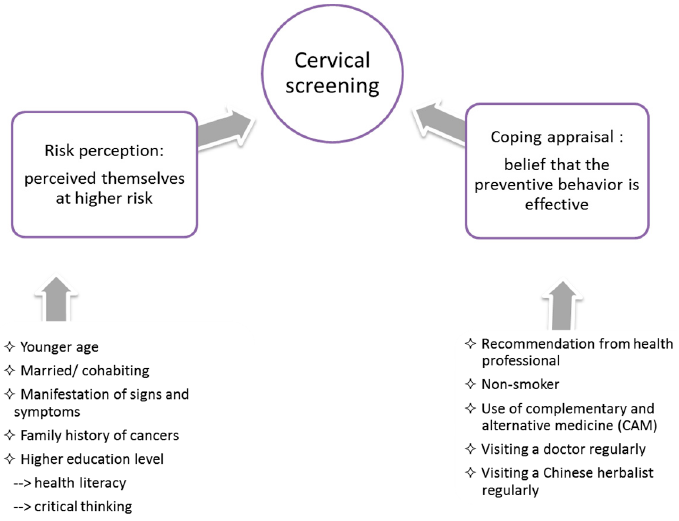
Figure 1. Factors associated with cervical cancer screening.